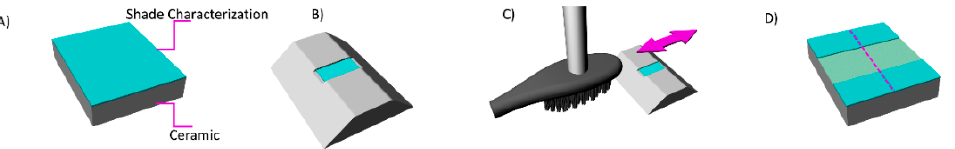
Figure 1. Study flowchart shows four Computer-aided design/computer-aided manufacturing CAD/CAM ceramics submitted to staining procedures prior to the toothbrushing simulation.